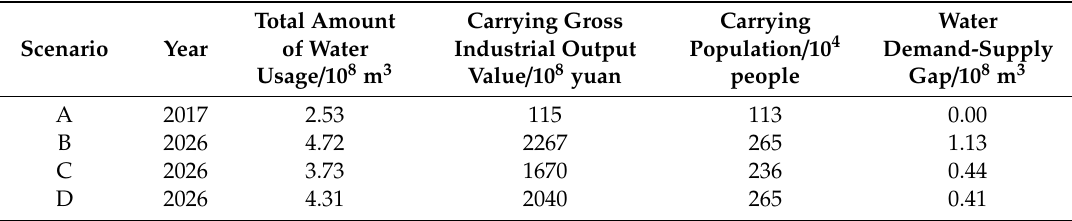
Table 2. The simulated water resources carrying capacity in the four scenarios in Xiong’an New Area.